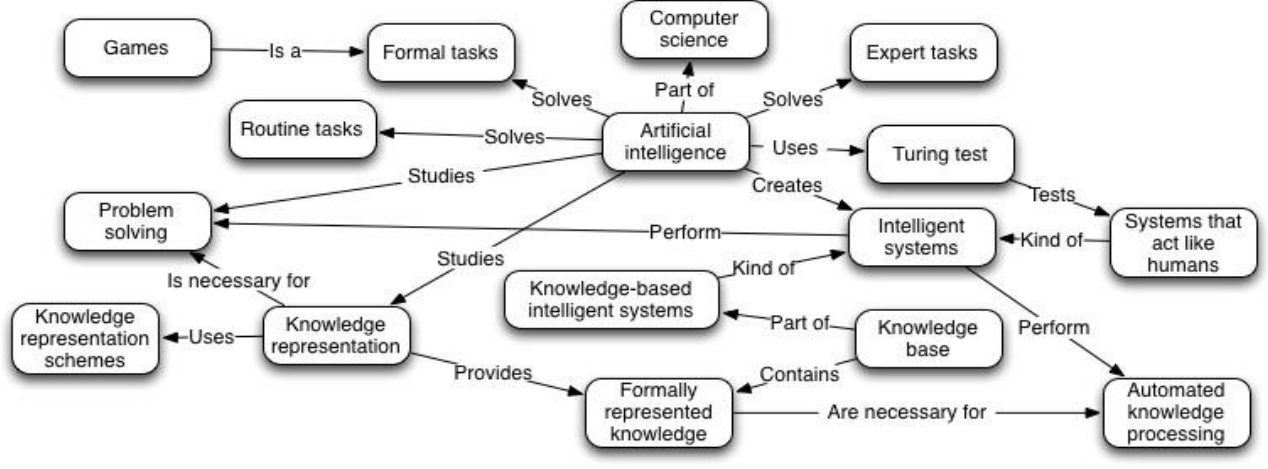
Fig. 2. Part of a reference model used for the study